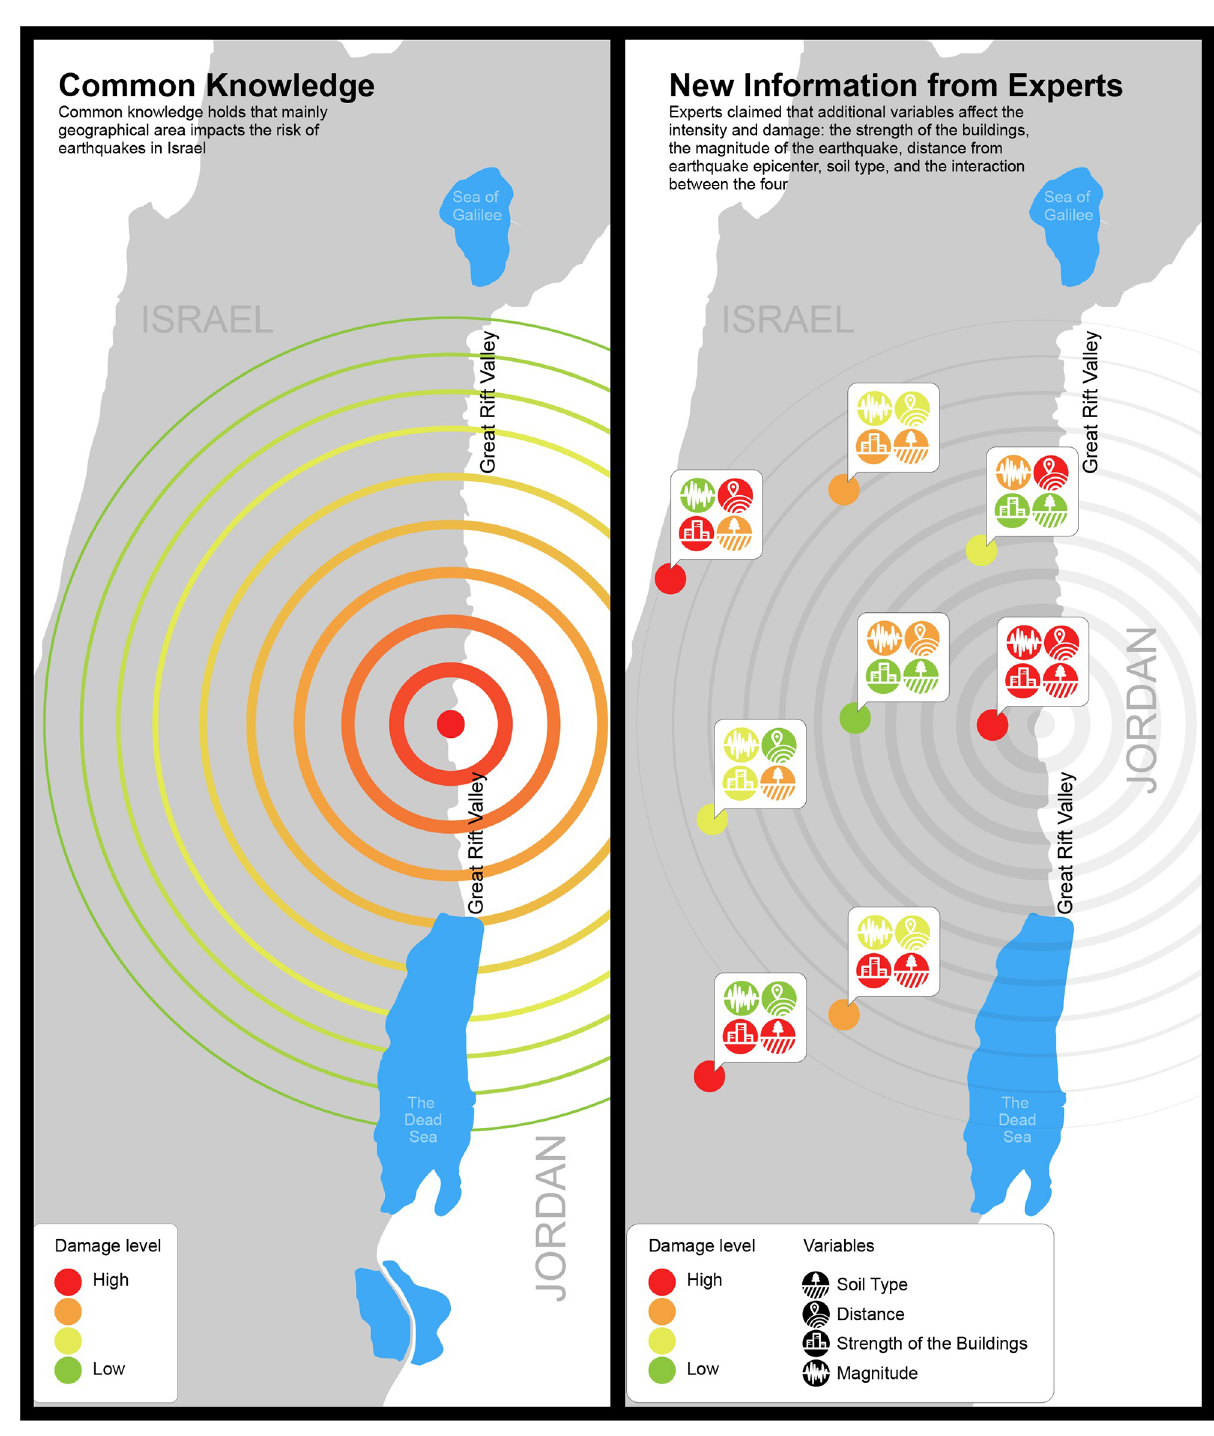
Fig 1. Common knowledge versus new information from experts regarding the earthquake factors. According to common knowledge, geographical area is the main factor affecting the risk of earthquakes in Israel, whereas new information from experts adds variables that affect earthquake intensity and damage: building strength, earthquake magnitude, distance from the earthquake epicenter, soil type, and the interaction between these four variables.